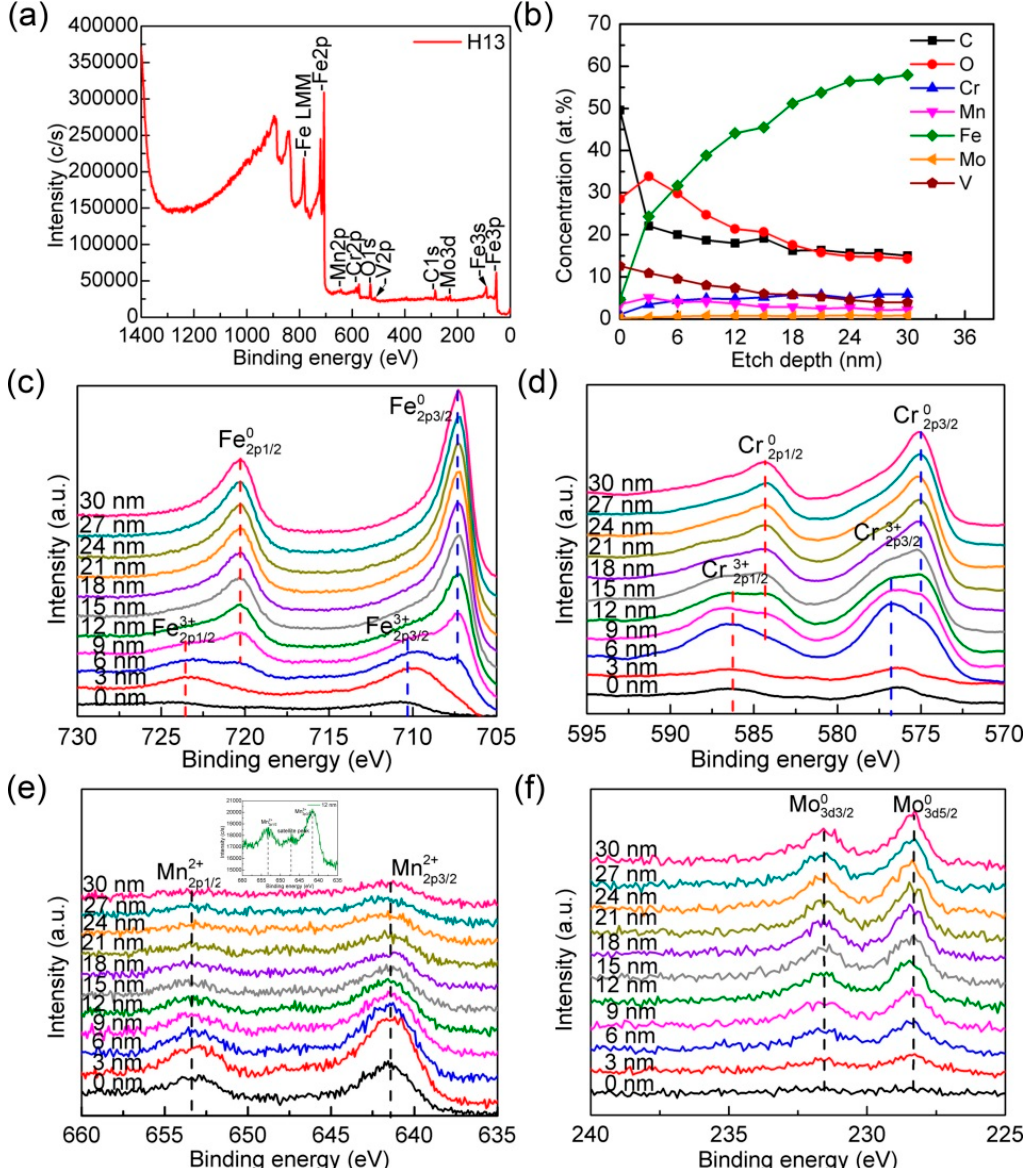
Figure A1. ( a ) XPS survey spectrum and ( b ) depth profile analyses of element concentrations, and detailed XPS spectra of ( c ) Fe, ( d ) Cr, ( e ) Mn and ( f ) Mo on the surface of H13 powders in the as-received state and after ion etching up to 30